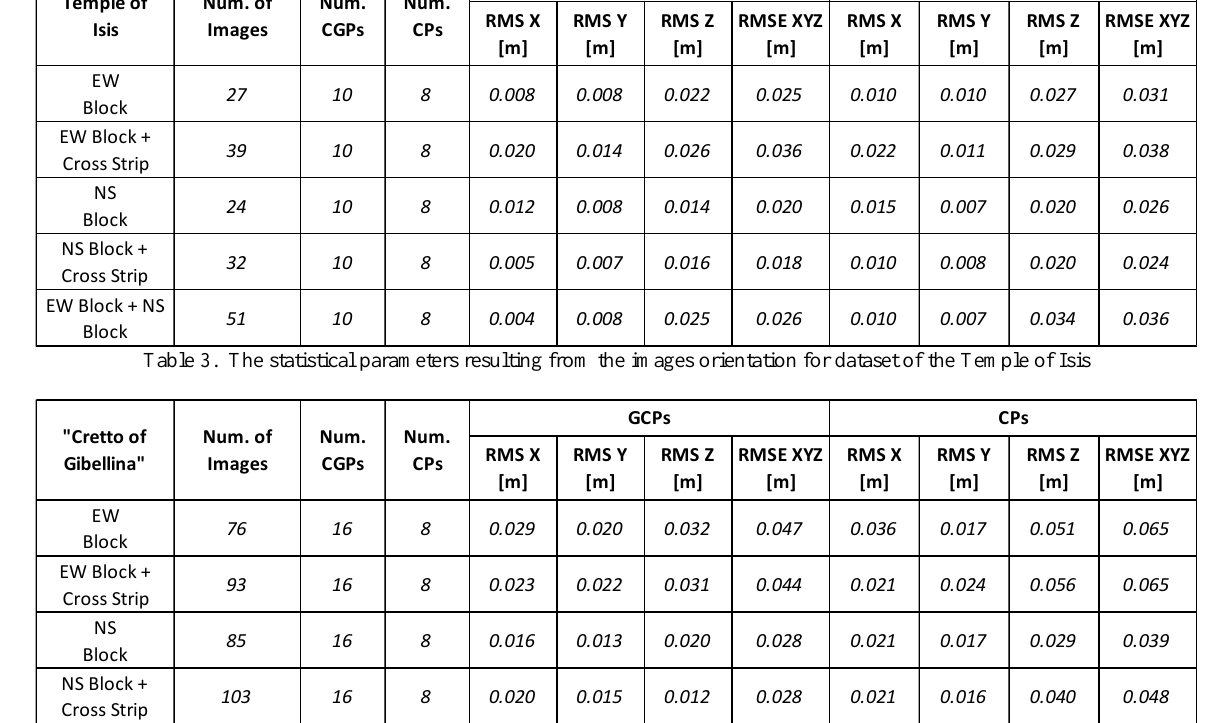
Table 4. The statistical parameters resulting from the images orientation for dataset of the “Cretto of